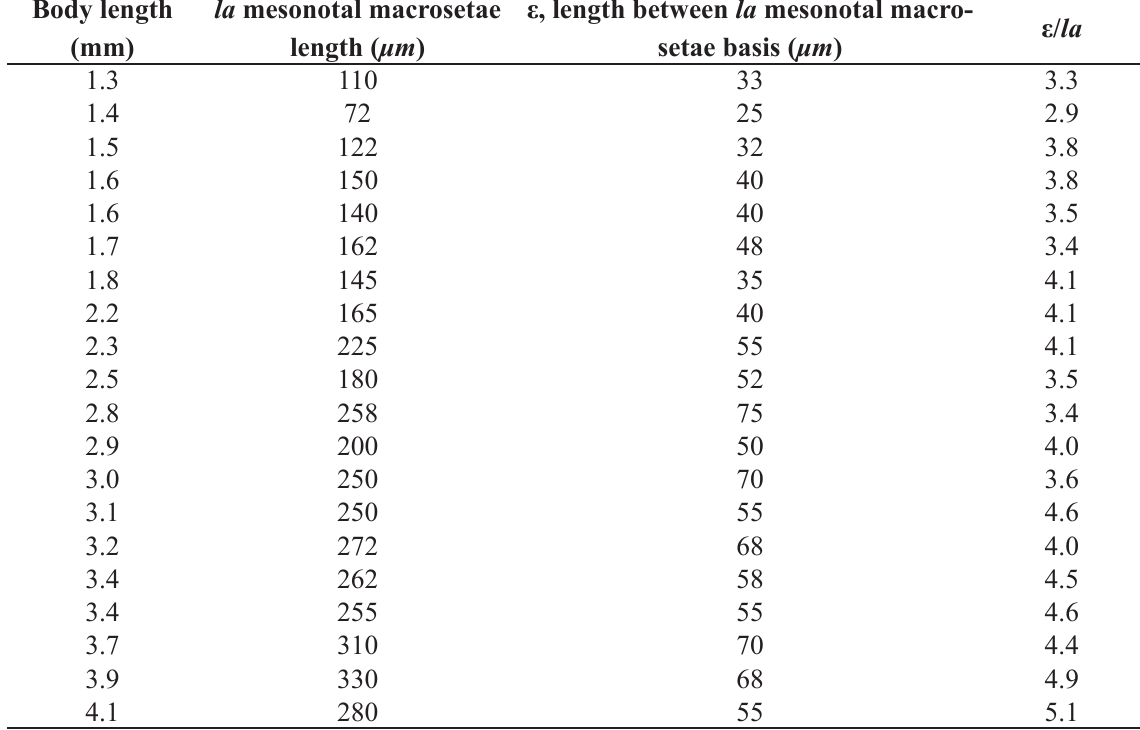
Table 3. Measurements of la macrosetae and distance between la basis (ε) on mesonotum of Campodea (Monocampa) emeryi emeryi Silvestri, 1912 from Sardinia